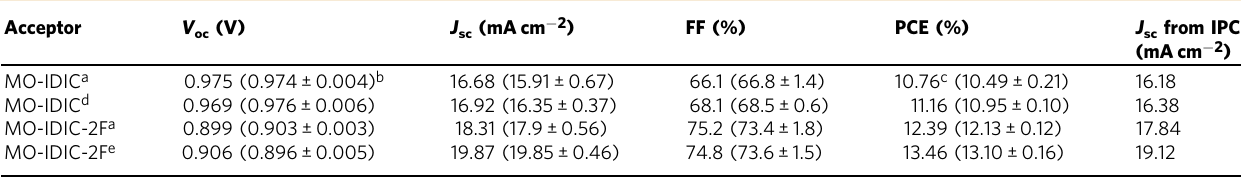
Table 1 Photovoltaic performance parameters of the PSCs based on PTQ10:acceptors (1:1, w/w) under the illumination of AM1.5 G, 100 mW cm −